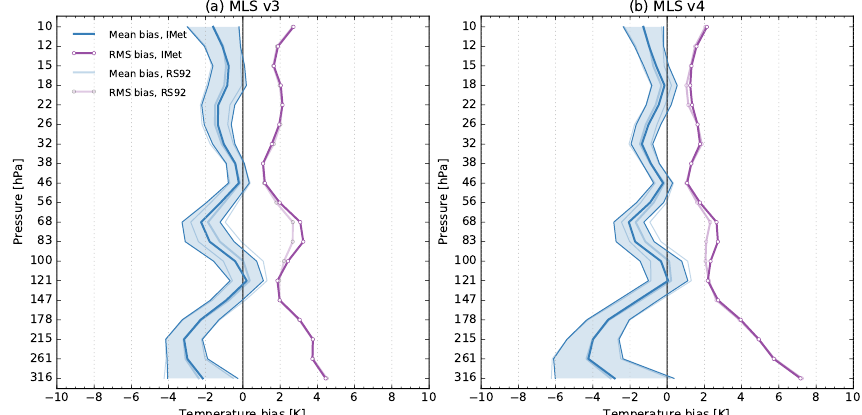
Figure 6. Mean and root mean square biases for (a) MLS v3 and (b) MLS v4 temperature retrievals relative to 17 temperature profiles at Lhasa and Linzhi measured using both InterMet (IMet) and RS92 radiosondes. Uncertainty bounds on the mean bias represent twice the standard error of the mean.